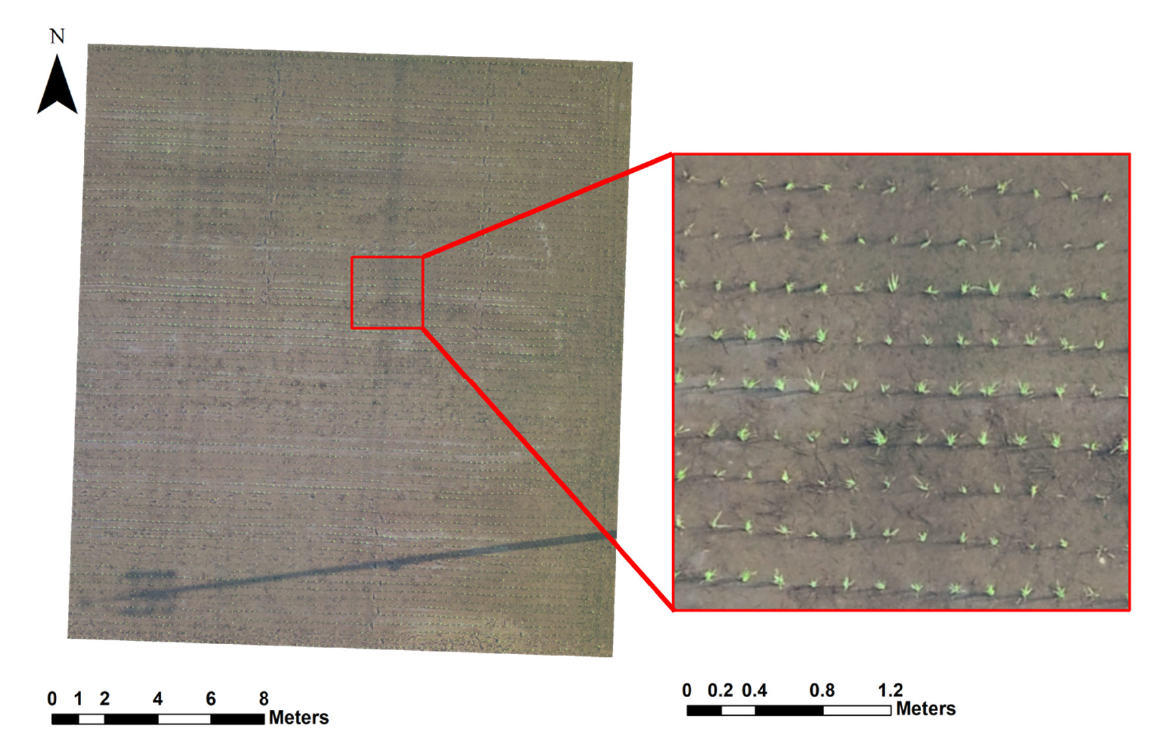
Figure 2. An overview of UAV image acquired on 7 August 2018. Reference system is TWD97 TM2 zone 121, EPSG: 3826.